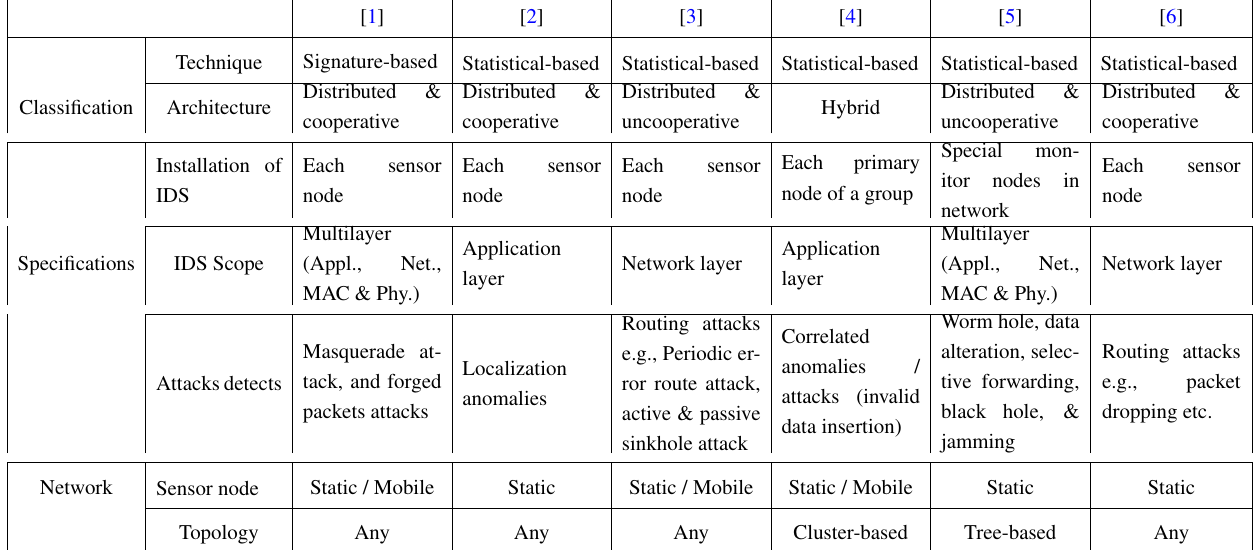
Table 1. Summarization of proposed Anomalies and IDS schemes of